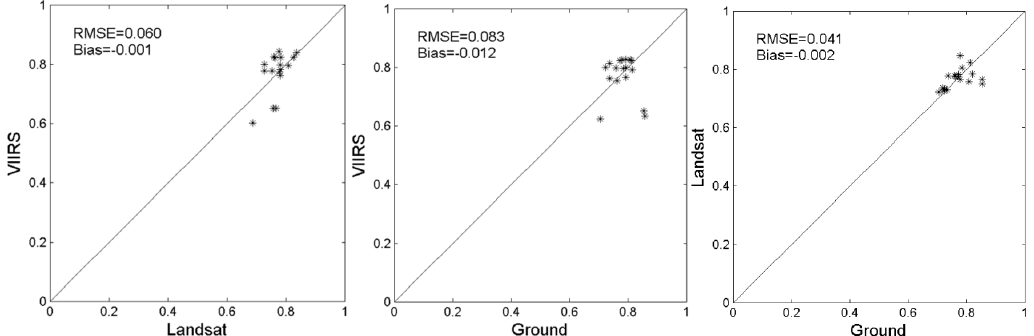
Figure 6. Intercomparison results (first column) between VIIRS LSA and Landsat-retrieved albedo for the years 2012 and 2013. Three individual sites (USWcr: first row; Desert Rock: second row; DYE-2: third row) covered by different land types are shown. In addition, comparisons with field measurements are also provided for the both products/retrievals in the second and third columns, respectively.